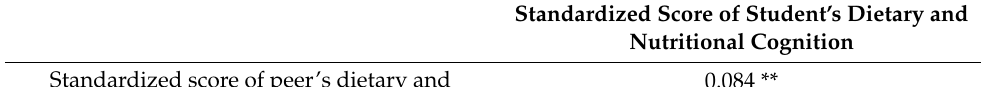
Table 3. Effects of peer’s dietary and nutritional cognition on student’s dietary and nutritional